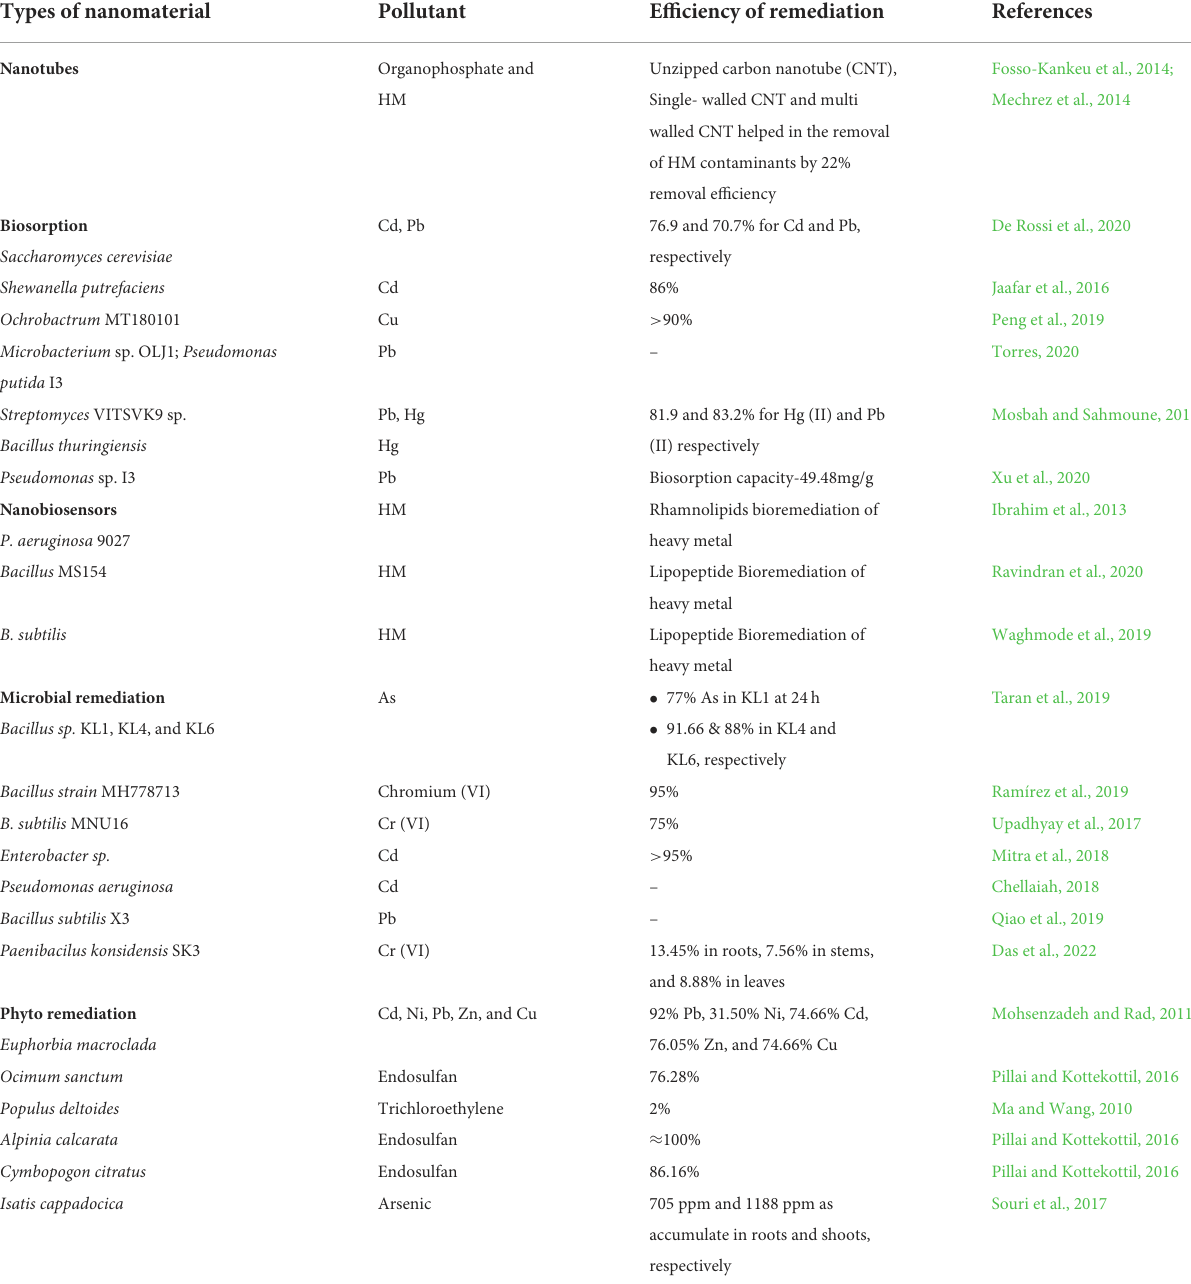
TABLE 1 Role of different types of nanomaterials remediating pollutants in